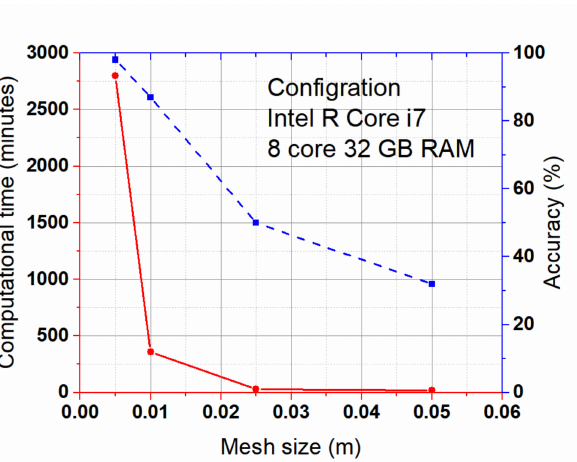
Figure 4. Mesh size vs. computational time and accuracy for breaking focused wave simulation in numerical wave tank modelled using